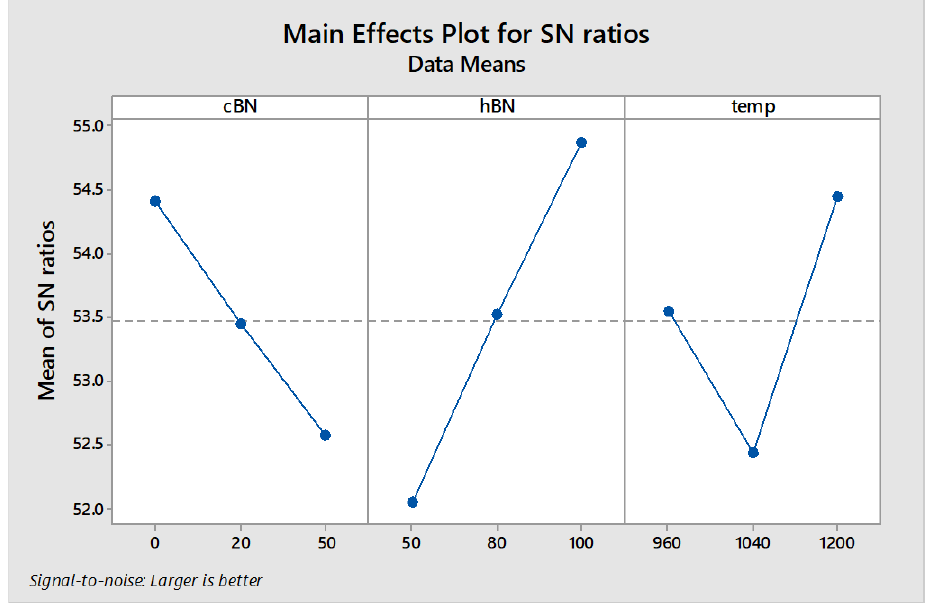
Figure 9. The mean S/N ratio for Microhardness.